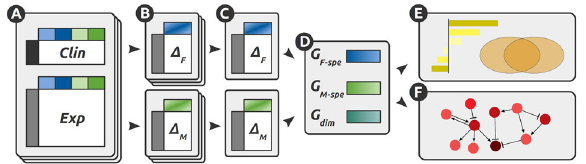
Fig. 4 Global work fl ow of the analysis. A Relevant PD transcrip- tomics datasets were collected from public transcriptomic data repositories and complemented by an RNA-seq dataset generated in-house using samples from the Netherlands Brain Bank (see section “ Data collection ” ). All datasets were curated and pre- processed (Clin: clinical data; Exp: experimental data; see “ Meth- ods ” ). B Two linear models were created to detect the genes differentially expressed between PD patients and controls, respec- tively for females ( Δ F , top, blue) and males ( Δ M , bottom, green). C For each model, a consensus was obtained through a meta- analysis across all datasets, favoring the genes with robust and reliable differential expression patterns. D Differentially expressed genes were then split into (i) female-speci fi c genes ( G F − spe , blue), (ii) male-speci fi c genes ( G M − spe , green) and (iii) candidate sex- dimorphic genes, whose directionality of the change differs between males and females ( G dim , turquoise). E Functional enrich- ment of the selected differentially expressed genes to detect which biological processes are impacted. F Regulatory network analysis of the full set of genes, using experimentally validated interactions collected from multiple